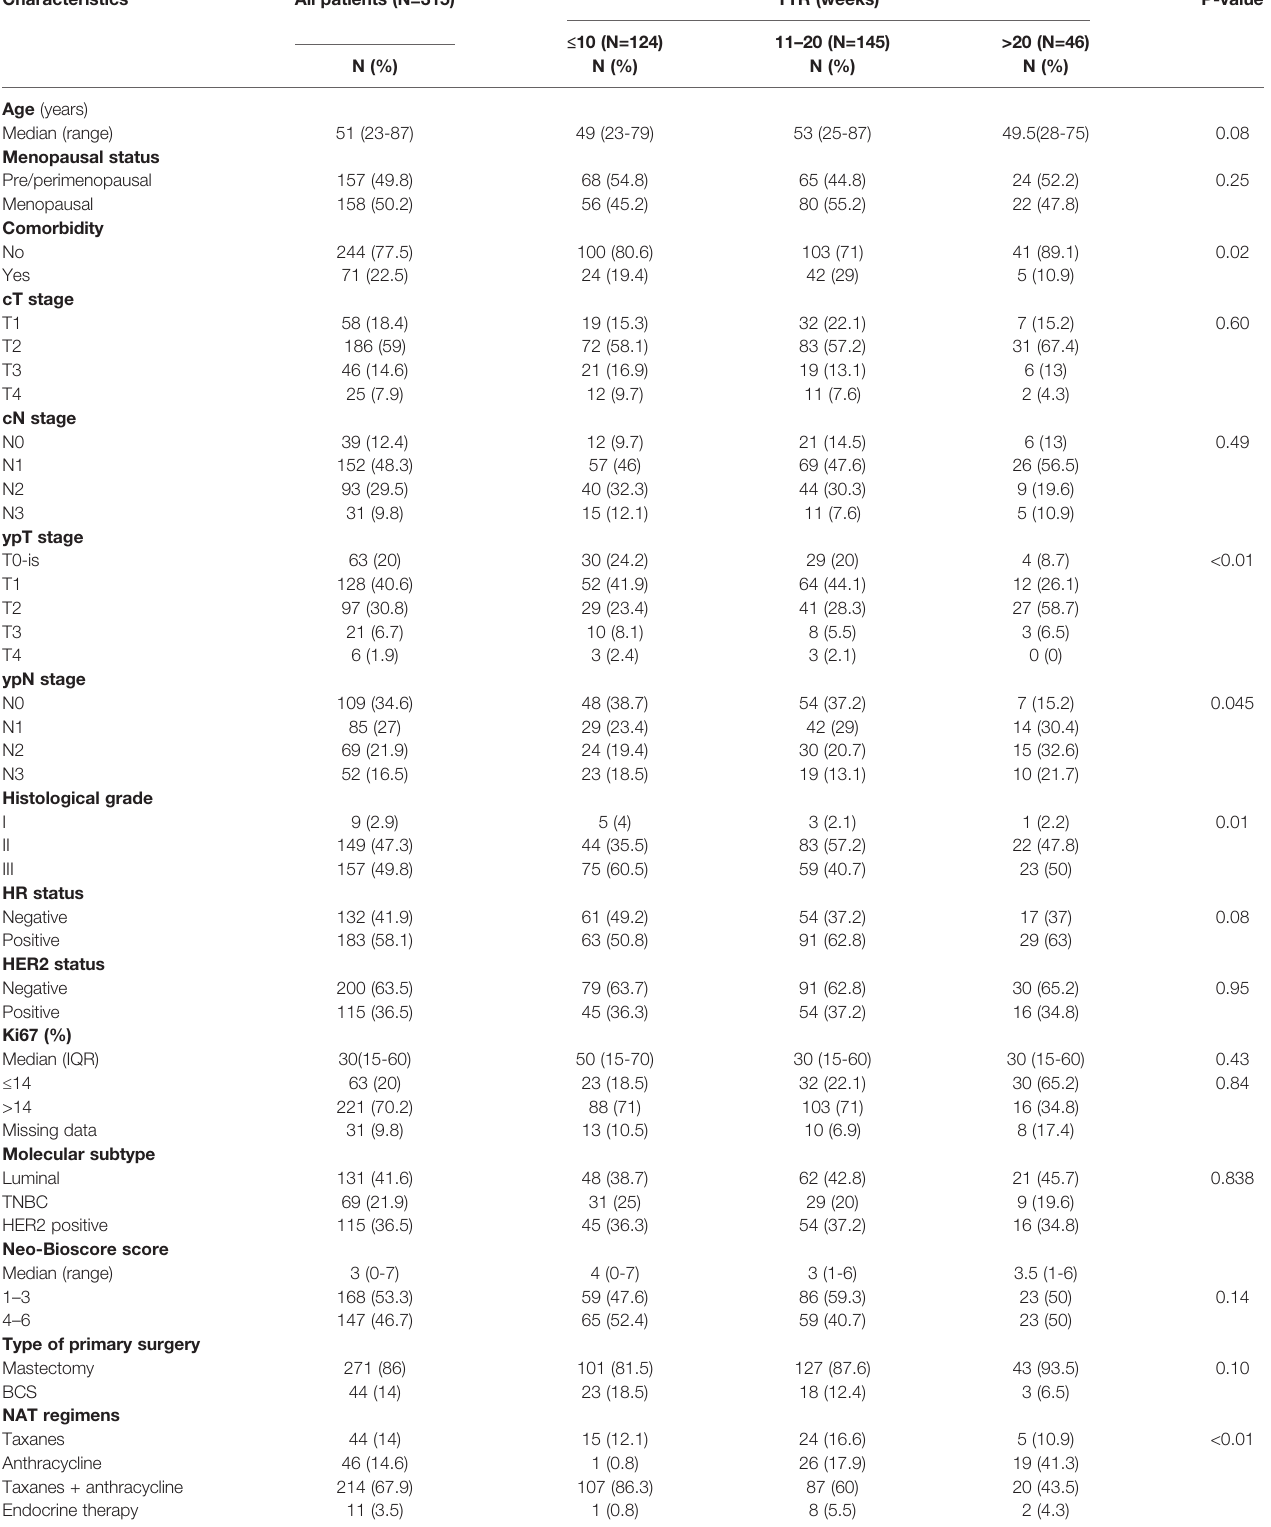
TABLE 1 | Patients and treatment characteristics by time to radiotherapy (TTR) among patients treated with neoadjuvant treatments (NATs).